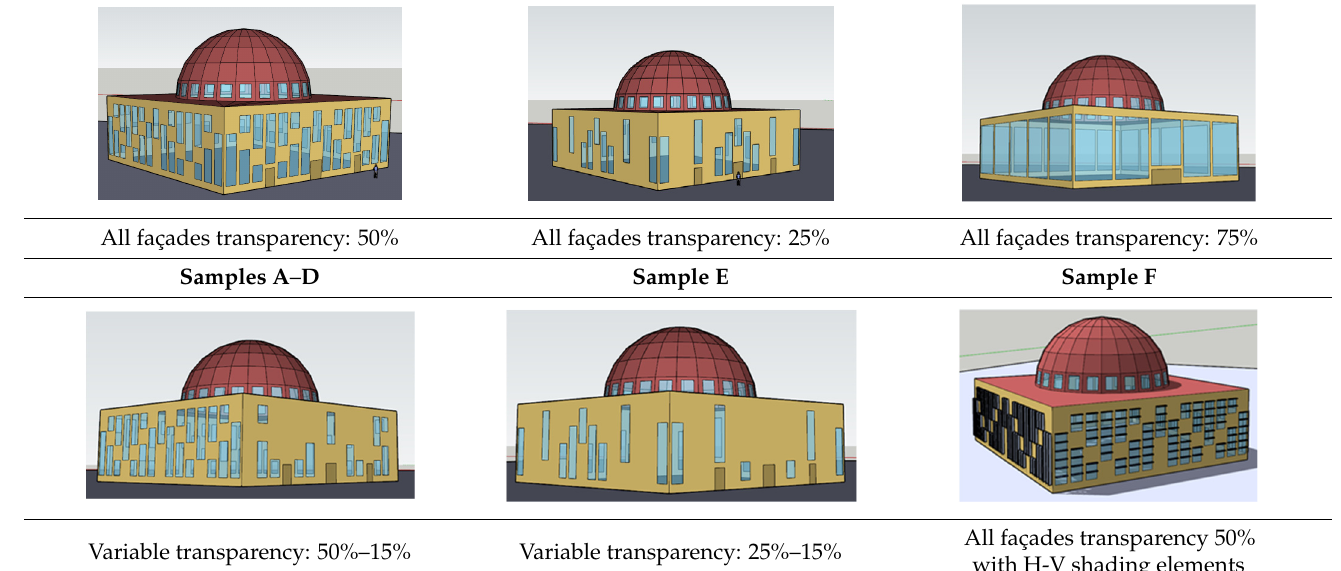
Table 5. The changed properties of the building envelope according to Sample A in the other scenarios.